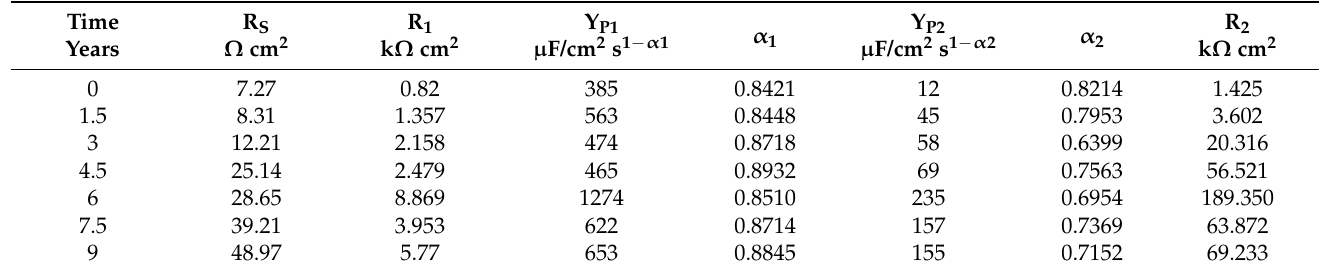
Table 2. Values of the characteristic parameters used in evaluating the behavior of steel embedded in alkaline-activated concrete, along with its response over